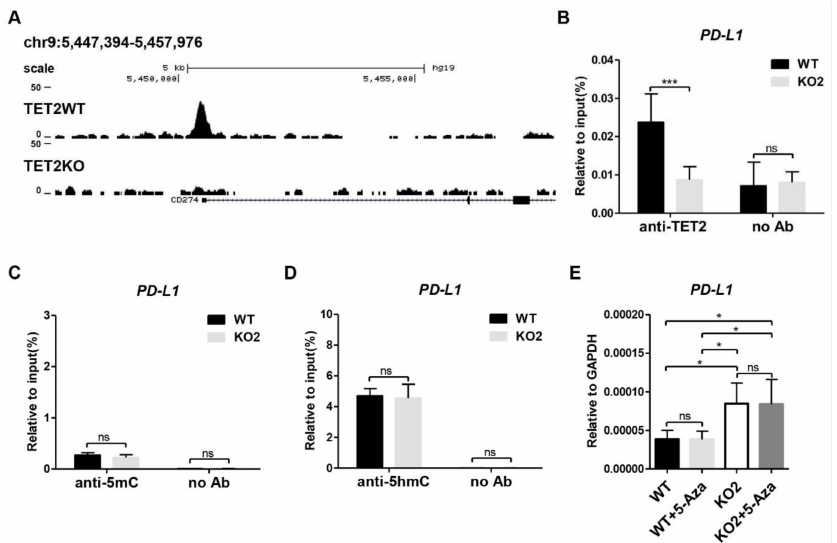
Figure 2. TET2 KO does not alter the DNA methylation and hydroxymethylation level at the promoter region of PD-L1 gene. ( A ) Snapshot of TET2 ChIP-seq data (GSE120756) at PD-L1 ( CD274 ) promoter in WT and TET2 KO MCF7 cells. ( B ) ChIP-qPCR validation of TET2 occupancy at PD-L1 promoter in WT and TET2 KO MCF7 cells. ( C ) MeDIP-qPCR analysis of 5mC enrichment at PD-L1 promoter in WT and TET2 KO MCF7 cells. ( D ) hMeDIP-qPCR analysis of 5hmC enrichment at PD-L1 promoter in WT and TET2 KO MCF7 cells. ( E ) RT-qPCR analysis of the relative mRNA expression levels of